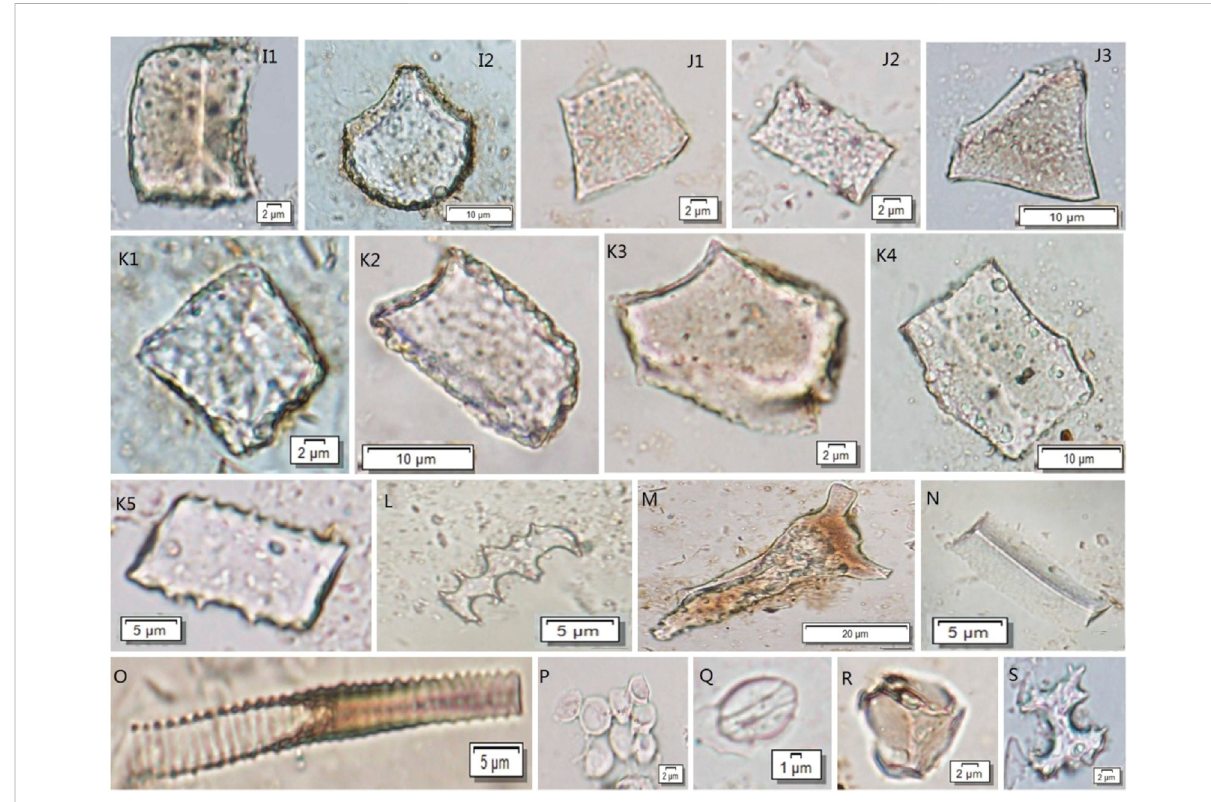
Thephytolith morphologytypesfromtheZZHpro fi leintheBadainJaranDesert.Fans (I1,I2) ;rectangles (J1 – J3) ;gobbets (K1 – K5) ; (L) carinate; (M) brachiate; (N) prismatic; (O) silici fi ed tracheids; (P) silici fi ed plant tissue; (Q) silici fi ed stomata; (R) epidermal phytolith; (S) special type.